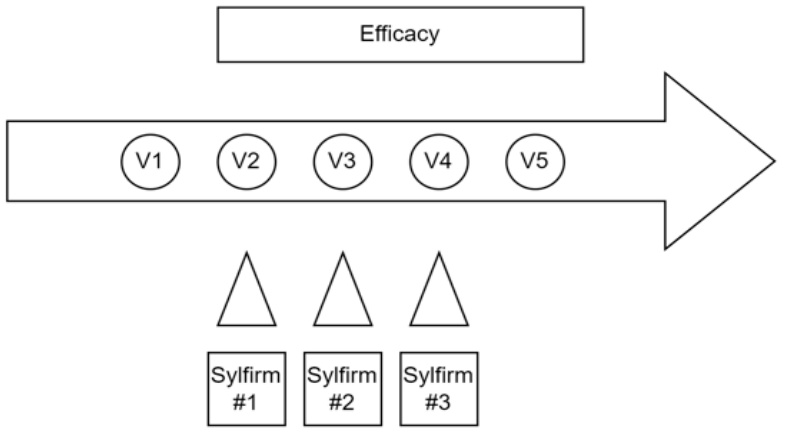
Figure 1. Study design and visit flowchart.